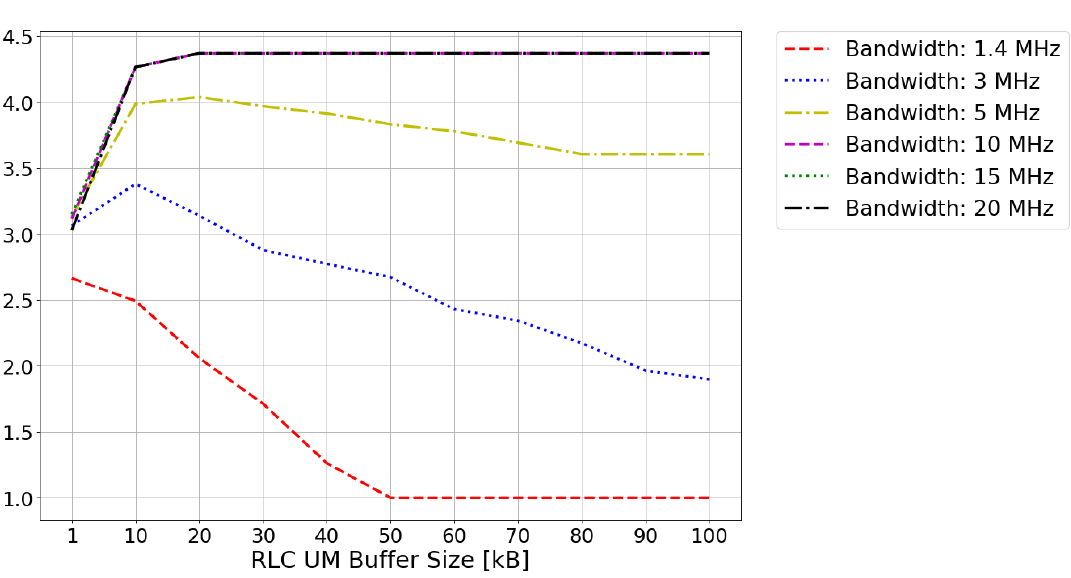
Figure 1. Expected mean opinion score (MOS) for different system bandwidths, as a function of the radio link control (RLC) unacknowledged mode (UM) buffer